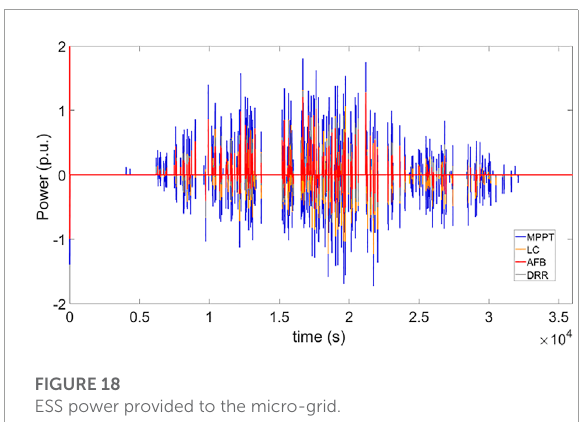
FIGURE 18 ESS power provided to the micro-grid.